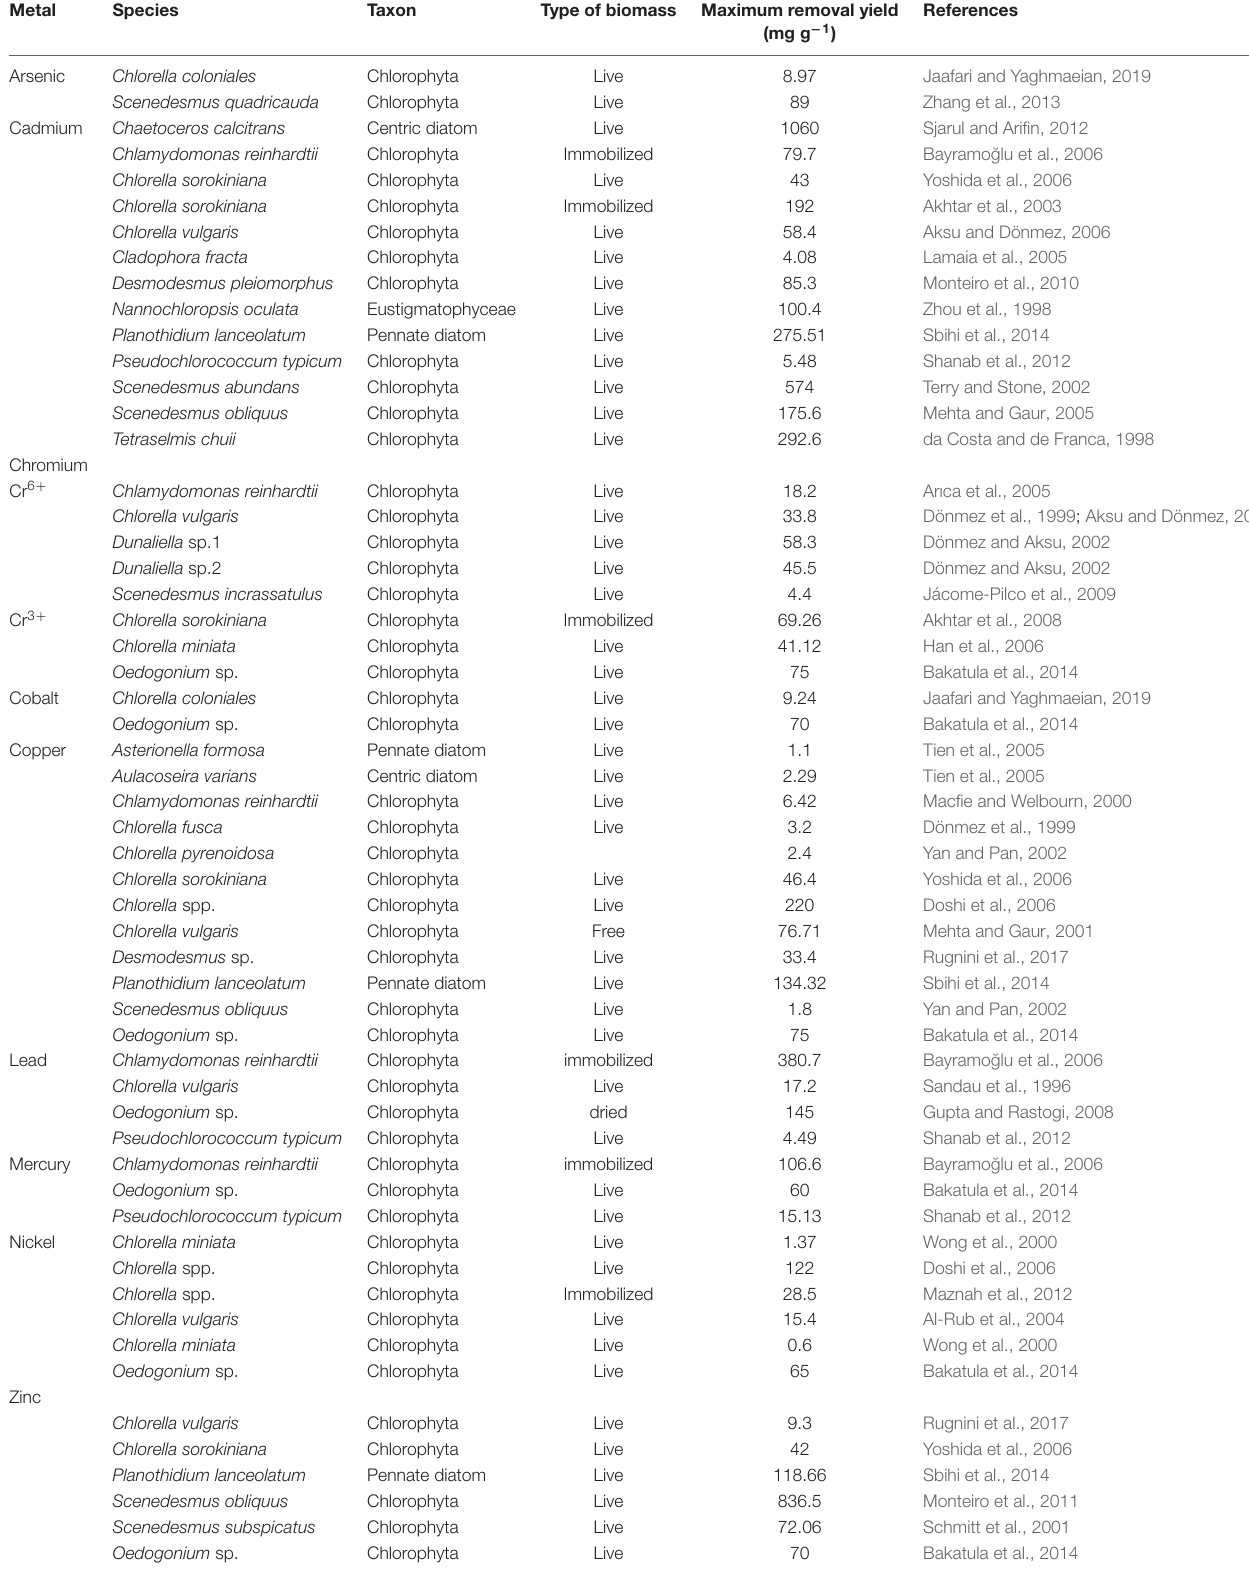
TABLE 2 | Microalgal species mostly used in heavy metal phycoremediation.